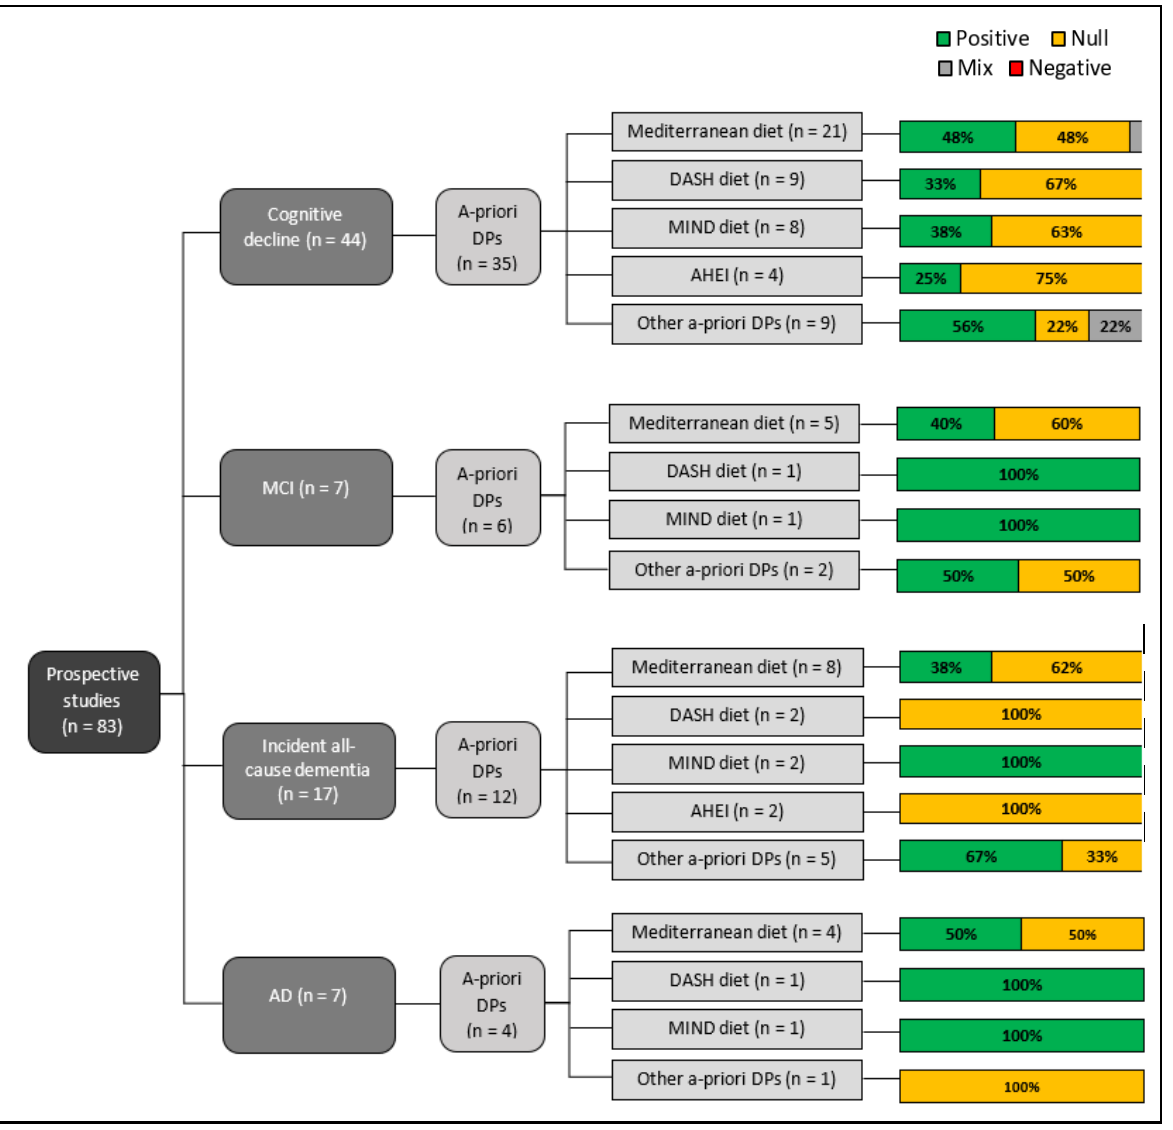
Figure 2. Overview of reported prospective associations between a -priori DPs, cognitive decline and incident cognitive disorder (% per number of included studies).